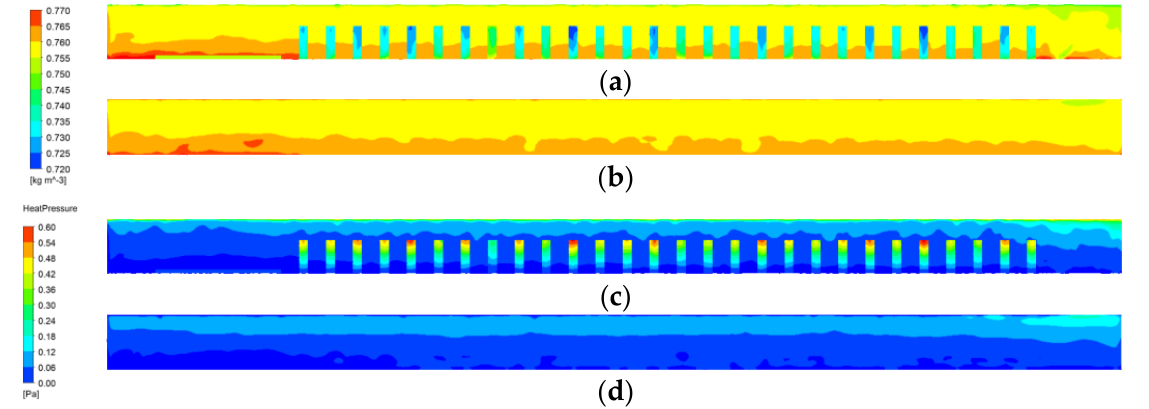
Figure 10. Variation in wind pressure characteristic parameters in high − altitude and plain areas of: ( a ) x = 4000 mm, Re; ( b ) x = 600 mm, Re; ( c ) x = 4000 mm, wind pressure; ( d ) x = 600 mm, wind pressure.